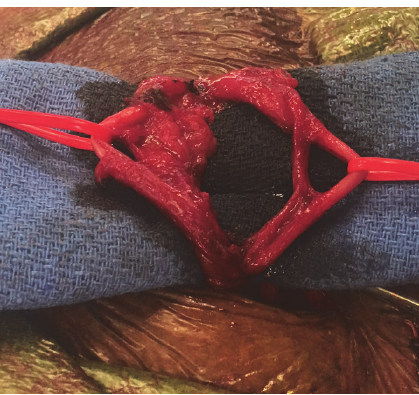
Figure 1: Duplicated vas deferens. 63-year-old male with duplica- tion of vas deferens incidentally discovered during right inguinal hernia repair. The duplicated vasa deferentia have been isolated with vessel loops (photo courtesy of Maxwell C.